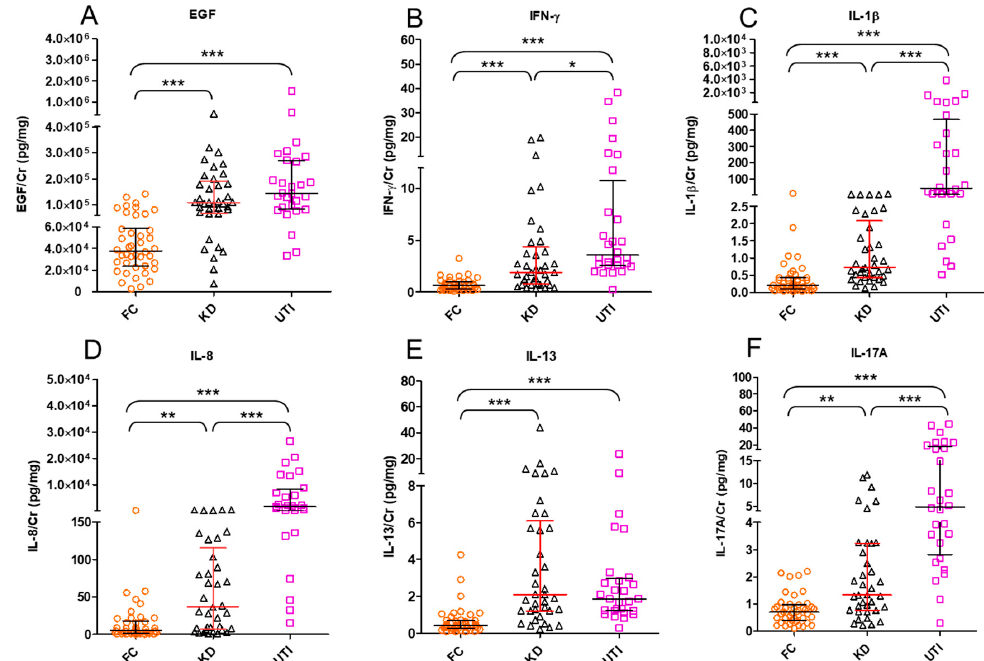
Figure 1. Differences in urinary cytokines between fever-control (FC), Kawasaki disease (KD), and urinary tract infection (UTI) groups. Levels of urinary cytokines corrected to urinary creatinine (Cr) in ( A ) epidermal growth factor (EGF), ( B ) interferon (IFN)- γ , ( C ) interleukin (IL)-1 β , ( D ) IL-8, ( E ) IL-13, and ( F ) IL-17A are expressed as median (IQR) by Kruskal– Wallis test. Asterisk indicates statistical significance * for p < 0.05, ** for p < 0.01, and *** for p < 0.001.